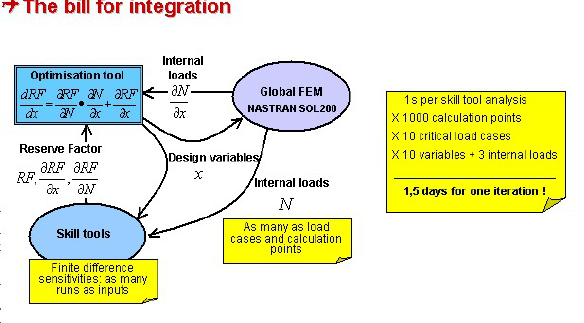
Fig. 13. Illustration of COMBOX computational times